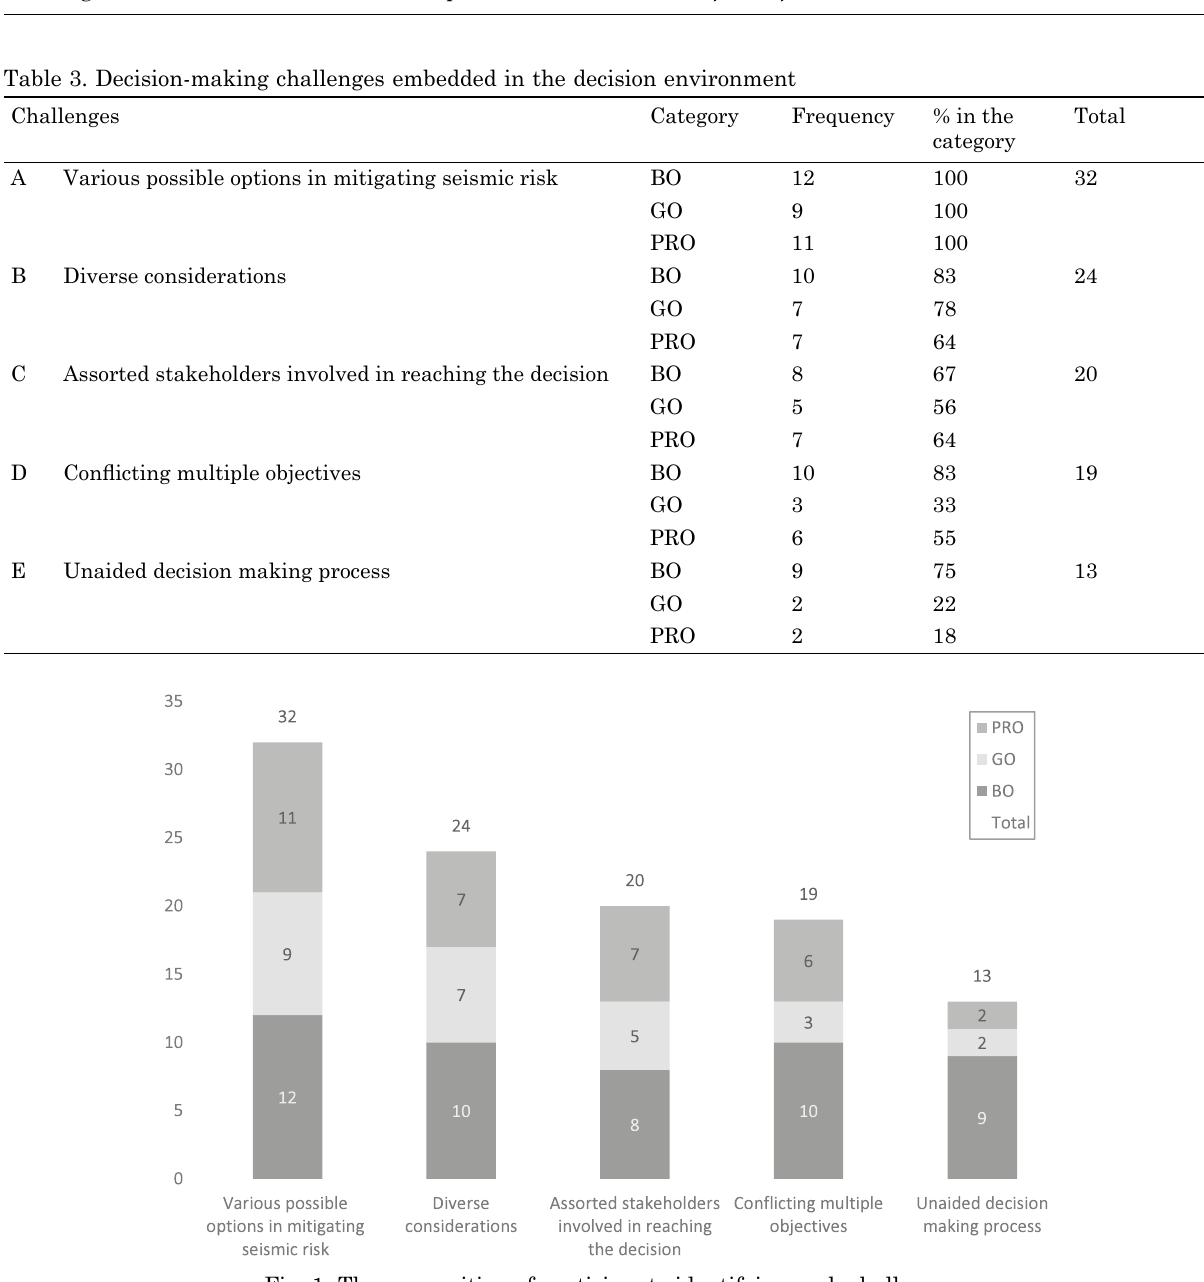
fig. 1. The composition of participants identifying each